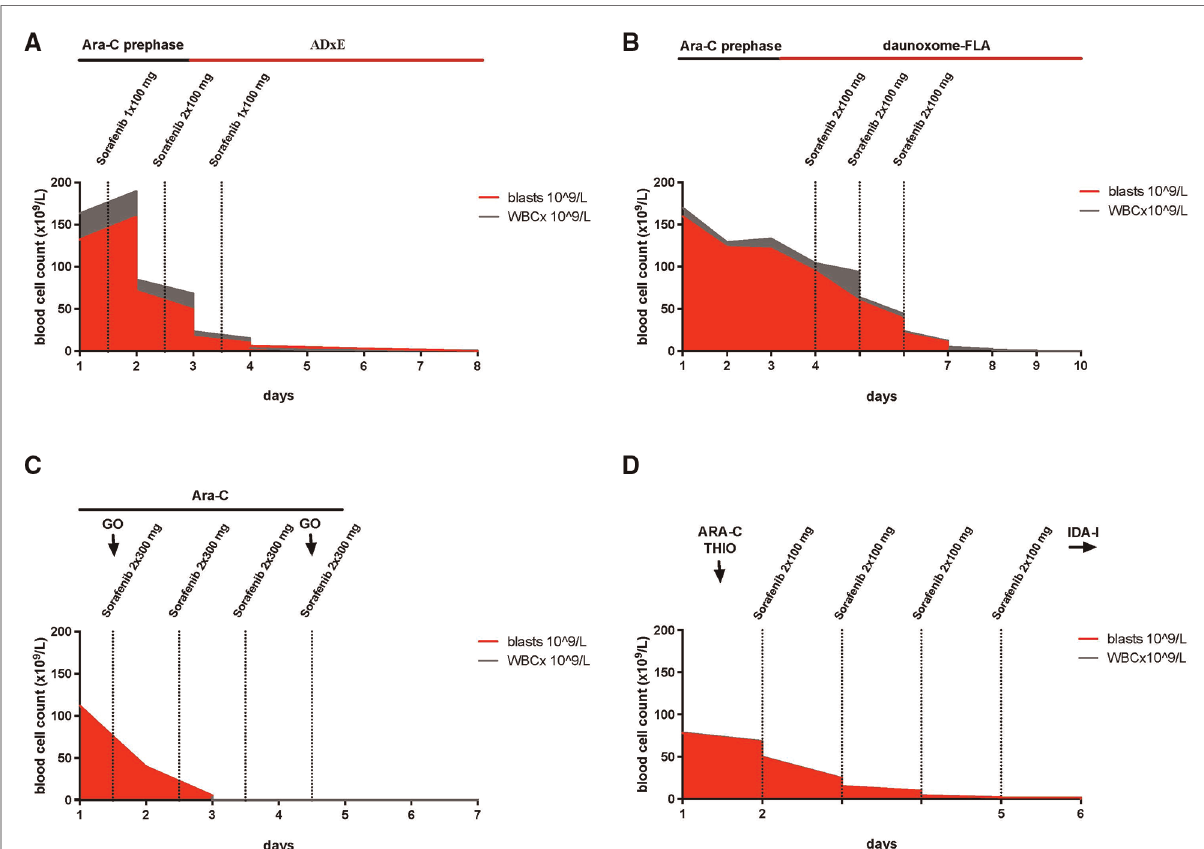
FIGURE 1 Timelines, illustrating the reduction of white blood cells during treatment with sorafenib and depicting the timing of chemotherapeutic treatment in relation to sorafenib. ( A ) Patient #1: Cytarabine (prephase Ara-C) was started together with sorafenib on day 1 with 1×100 mg, increasing the dose to 2×100 mg on day 2 and 1×200 mg on day 3, on day three induction with intravenous therapy with cytarabine, liposomal daunorubicin and etoposide and intrathecal therapy with cytarabine, methotrexate and prednisolone (ADxE). ( B ) Patient #2: Due to an inadequate response to the cytoreductive prephase with cytarabine (100 mg/m 2 /day continuous infusion) for 3 days (prephase Ara-C), sorafenib (2×100 mg/day) was administrated parallel to daunoxome-FLA consisting o fi ntravenous therapy with liposomal daunoxome, fl udarabine, cytarabine and intrathecal therapy with cytarabine, methotrexate and prednisolone for 3 days. ( C ) Patient #3: For 4 days, sorafenib (2×300 mg/day) was administrated in combination with cytarabine, 500 mg/m 2 /day, (Ara-C), and gemtuzumab ozogamicin, 2×5 mg, (GO). ( D ) Patient #4: On day 2 of treatment with cytarabine, 37.5 mg/m 2 , (ARA-C) and thioguanine, 33 mg/m 2 , (THIO), the treatment was expanded by sorafenib (2×100 mg/day) for 4 days, followed by cytarabine without idarubicine